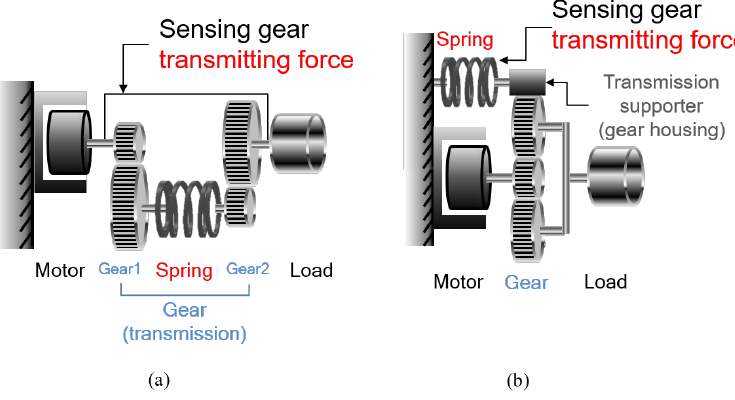
Figure 8. Configurations of Transmitted Force-sensing Series Elastic Actuator (TFSEA). ( a ) “internal transmitted force of gear” Sensing type and ( b ) “external transmitted force of gear” Sensing type.